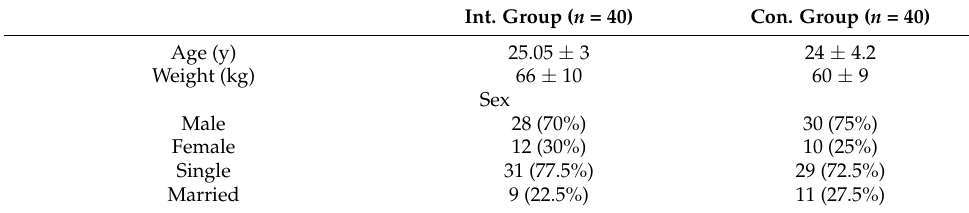
Table 1. Baseline participant demographics. Interventional group (Int.) is the group receiving stan- dard care plus the Denneroll™ thoracic traction orthotic (DTTO). Control group (Con.) is the group receiving standard care only. Values are expressed as means ± standard deviation where